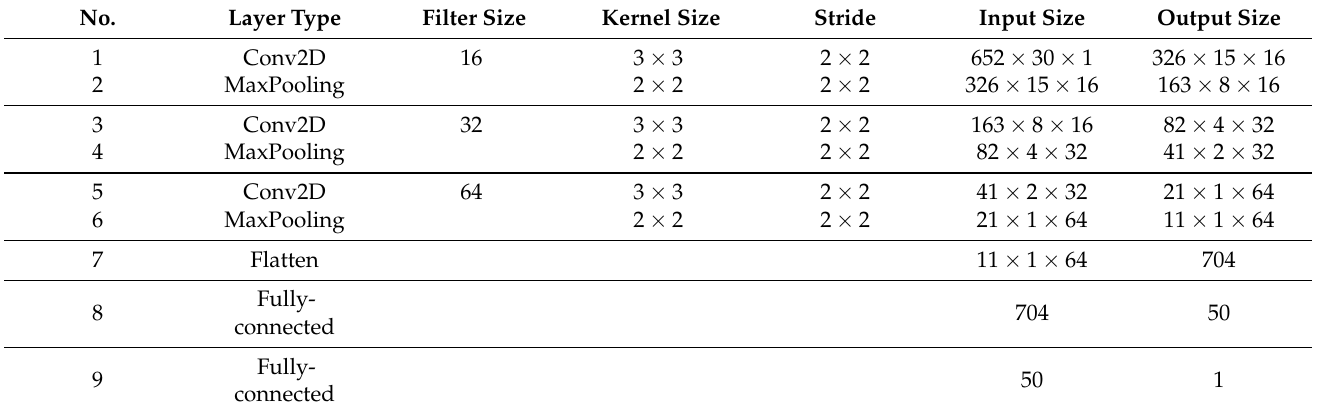
Table 4. The architecture of CNN. The reported dimensions are for